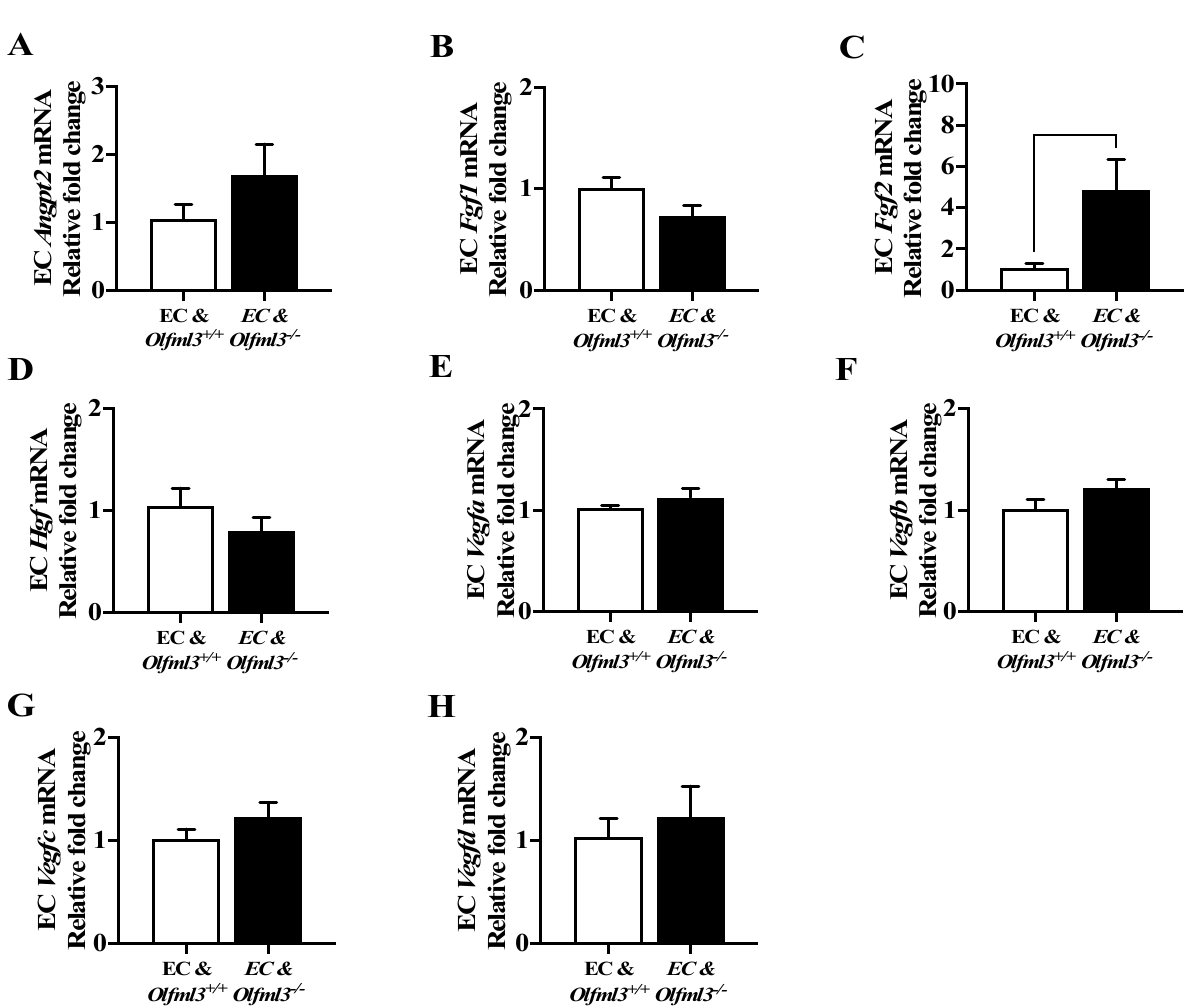
Figure 5. Brain EC expression of most pro-angiogenic genes is not influenced by the absence of microglial Olfml3. mRNA levels of ( A ) Angpt2 ( p = 0.2619), ( B ) Fgf1 ( p = 0.1174), ( D ) Hgf , ( E ) Vegfa ( p = 0.3186), ( F ) Vegfb ( p = 0.1311), ( G ) Vegfc ( p = 0.2455) , and ( H ) Vegfd ( p = 0.6027) were unchanged in ECs co-cultured with isogenic control and Olfml3 − / − microglia. ( C ) mRNA levels of Fgf2 were increased in ECs co-cultured with Olfml3 − / − microglia relative to ECs co-cultured with isogenic control microglia. Comparisons based on unpaired student’s t test; bars represent group mean with standard error of the mean (SEM).